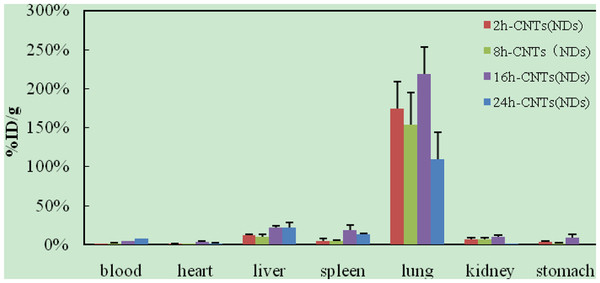
Biodistribution of oMWCNTs in mice at 2, 8, 16, and 24 h post i.v. with 99mTc-oMWCNTs + NDs.